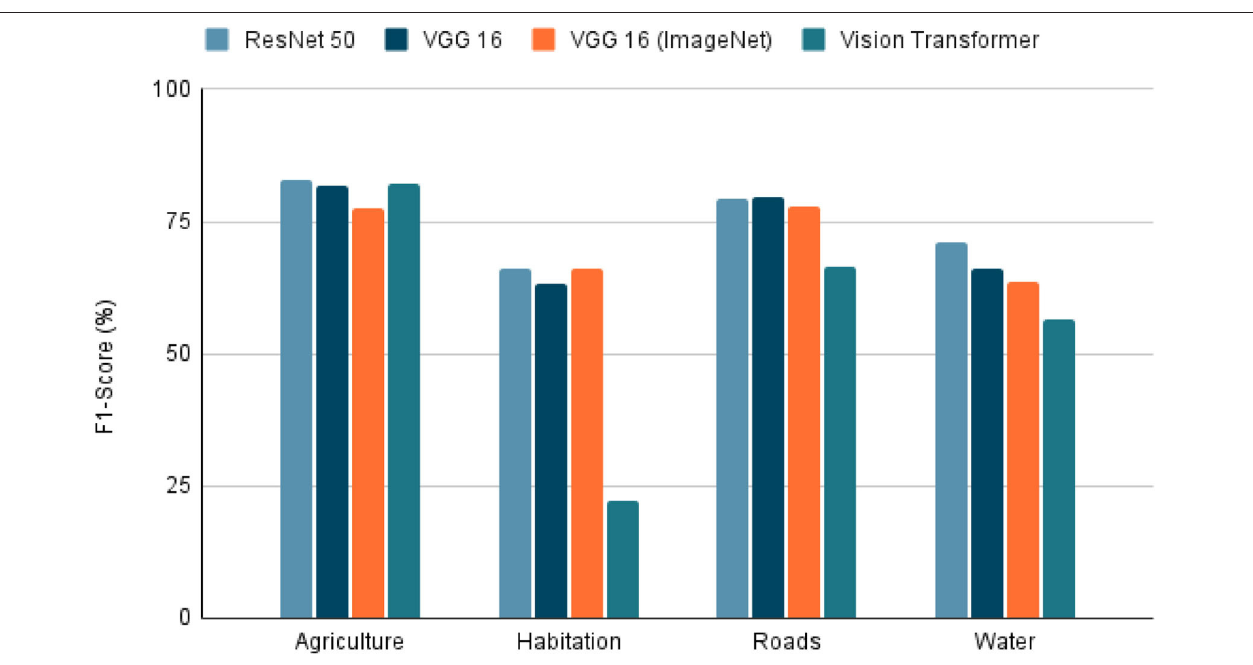
Likewise, as an alternative to the lack of some data, the option of using satellite images is presented. A method is proposed to extract characteristics from these and integrate them into a